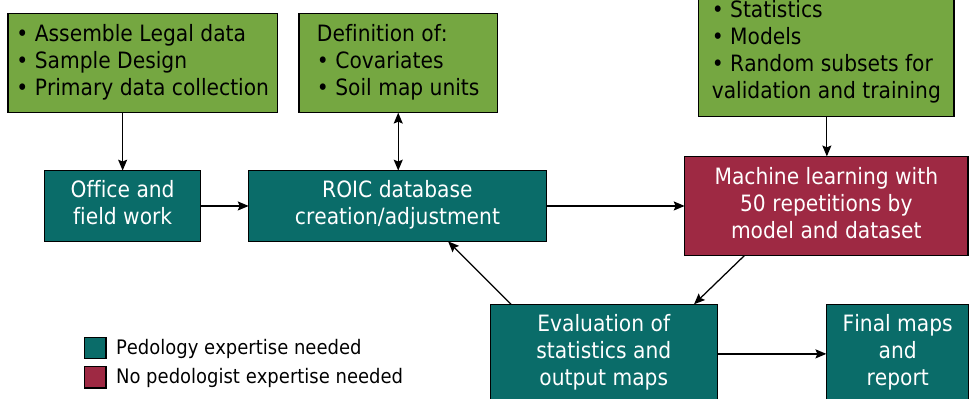
Figure 3. Flow chart summarizing the methodology used in the